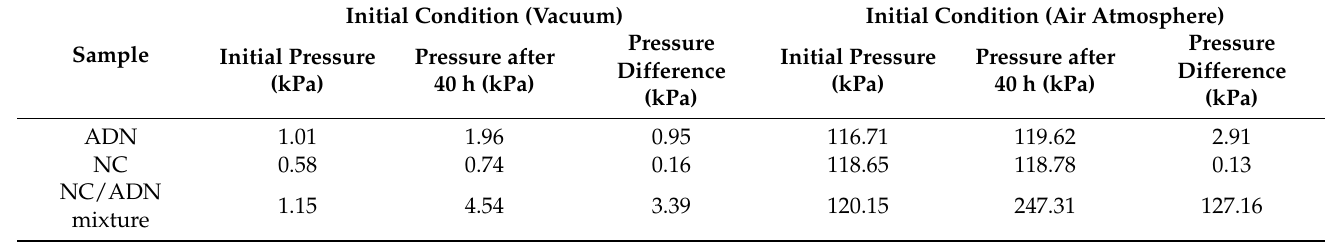
Table 2. The characteristic temperature and time of ADN, NC, NC/ADN mixture under qua- si-adiabatic conditions.